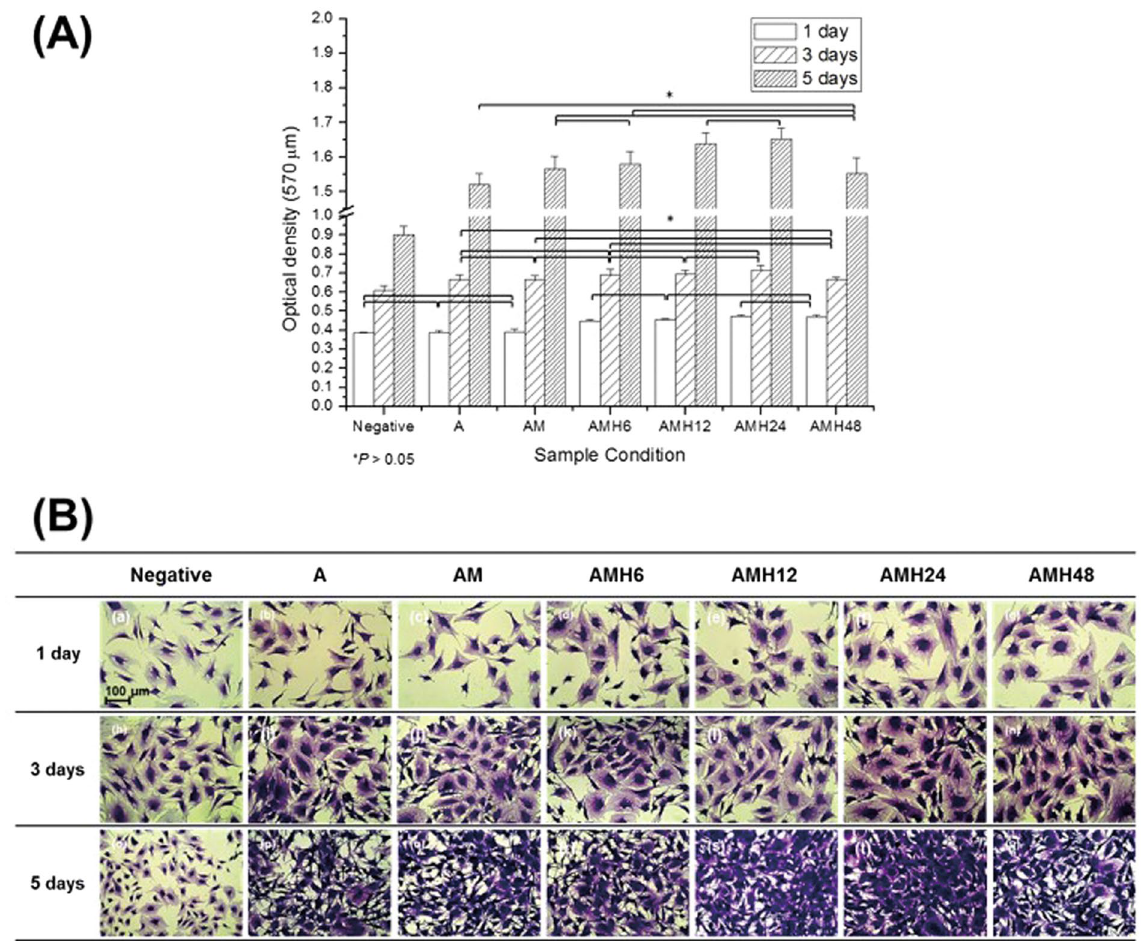
Figure 5. ( A ) Viability and ( B ) Morphology of MC3T3-E1 cells cultured for 1, 3 and 5 days in extracted media of the A, AM, AMH6, AMH12, AMH24 and AMH48 groups, as determined by WST assay and